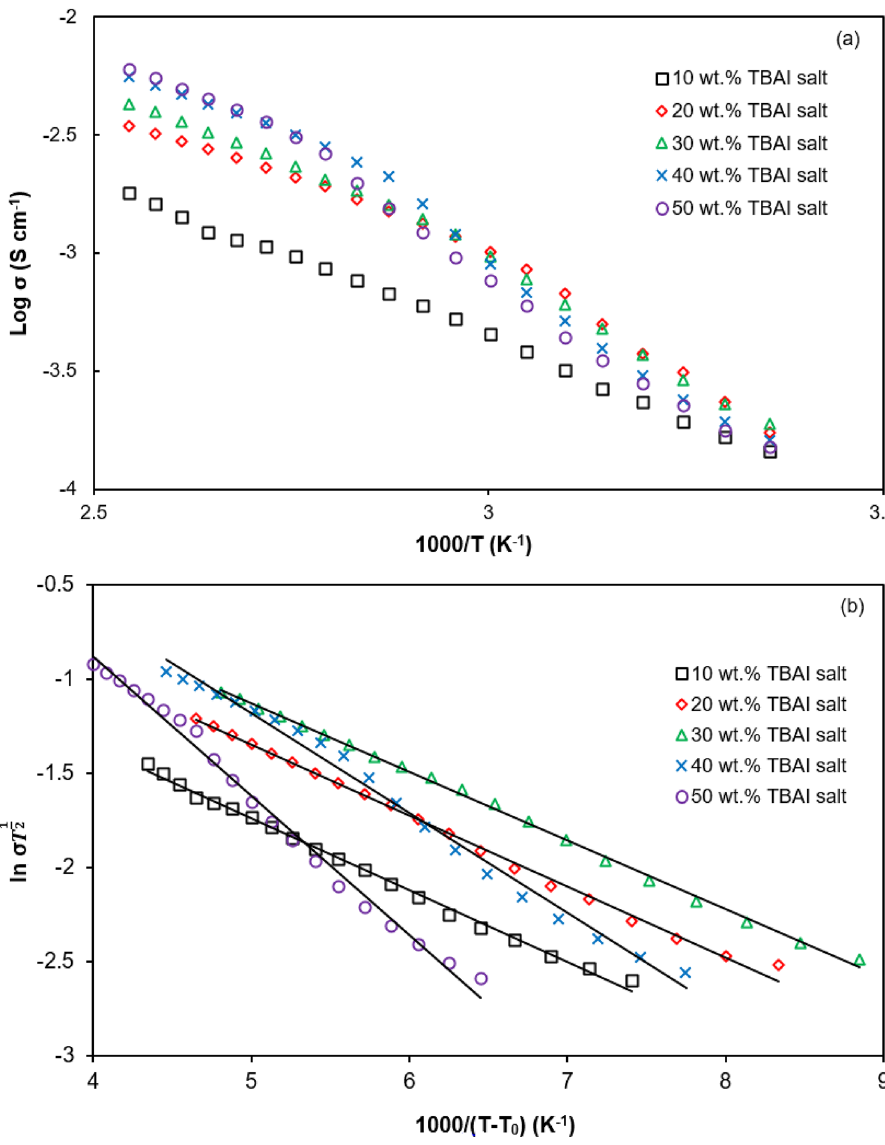
Figure 2. Temperature dependence of ionic conductivity followed ( a ) Arrhenius relationship and ( b ) VTF relationship for PUA-TBAI-I 2 gel electrolyte